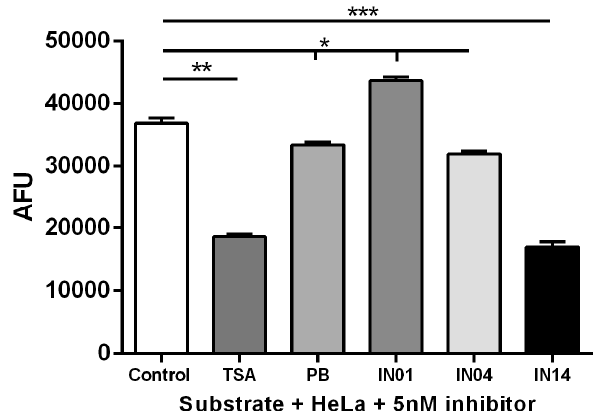
Figure 3. IN14 inhibits HDAC activity in HeLa Nuclear Extract. Data are expressed as mean ± SEM. Experiments were performed by technical triplicate. HDAC activity (arbitrary fluorescent units [AFU]); PB: phenylbutyrate; TSA: Trichostatin A (positive control); IN01-IN04-IN14: synthesized compounds. * p < 0.05, ** p < 0.01, *** p < 0.001 vs. control.